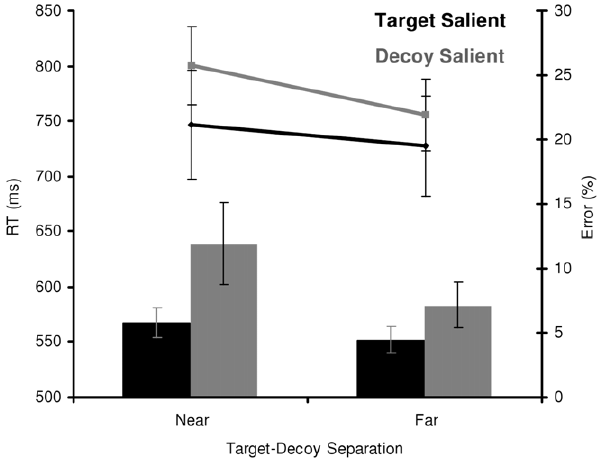
Figure 5. Behavioral results for Experiment 2. Mean reaction time (line) and error rates (bars) as a function of target-decoy separation and relative salience for the orientation discrimination task in Experiment 2. Error bars are standard error. Note that participants were slower and committed more errors as the target and decoy get closer together. Additionally, participants were slower and committed more errors when the decoy was relatively more salient than the target but only when the target and decoy were near each